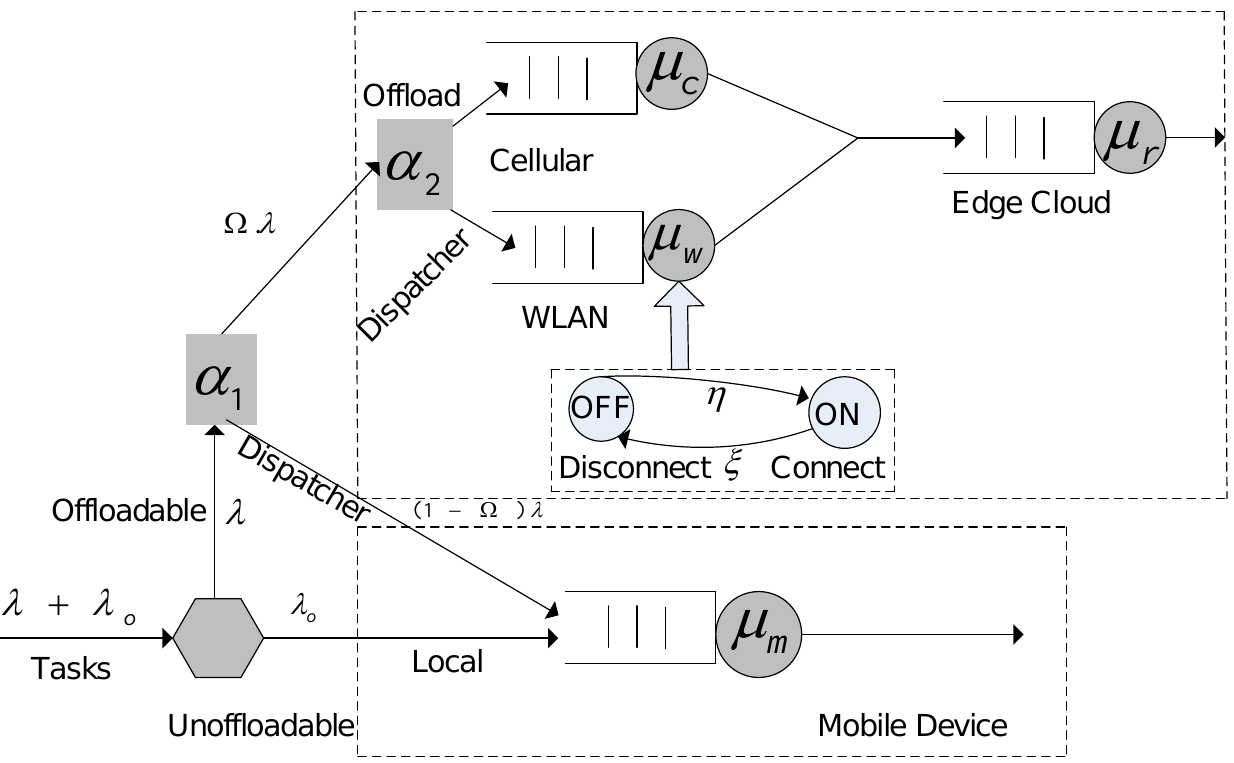
Figure 5. Failure-aware environment in the proposed